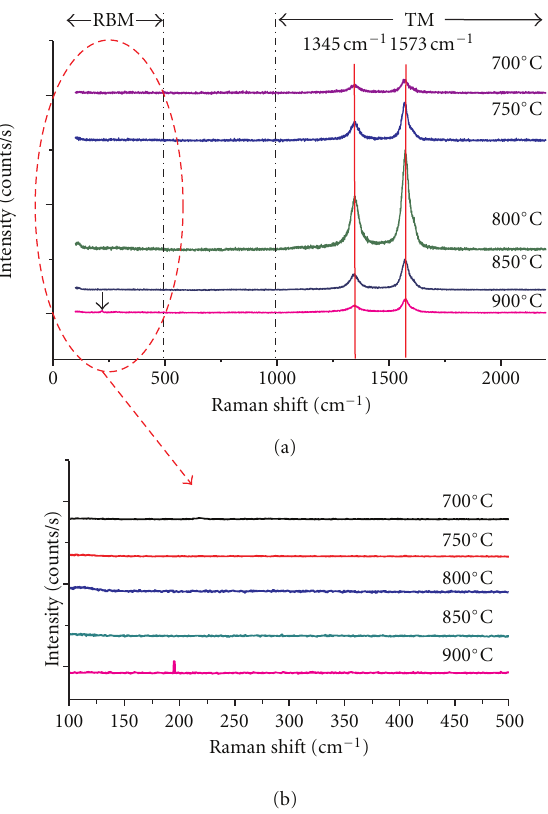
Figure 4: (a) Micro-Raman analysis of aligned CNT at di ff erent synthesis temperature and (b) inset of micro-Raman spectra for RBM analysis.